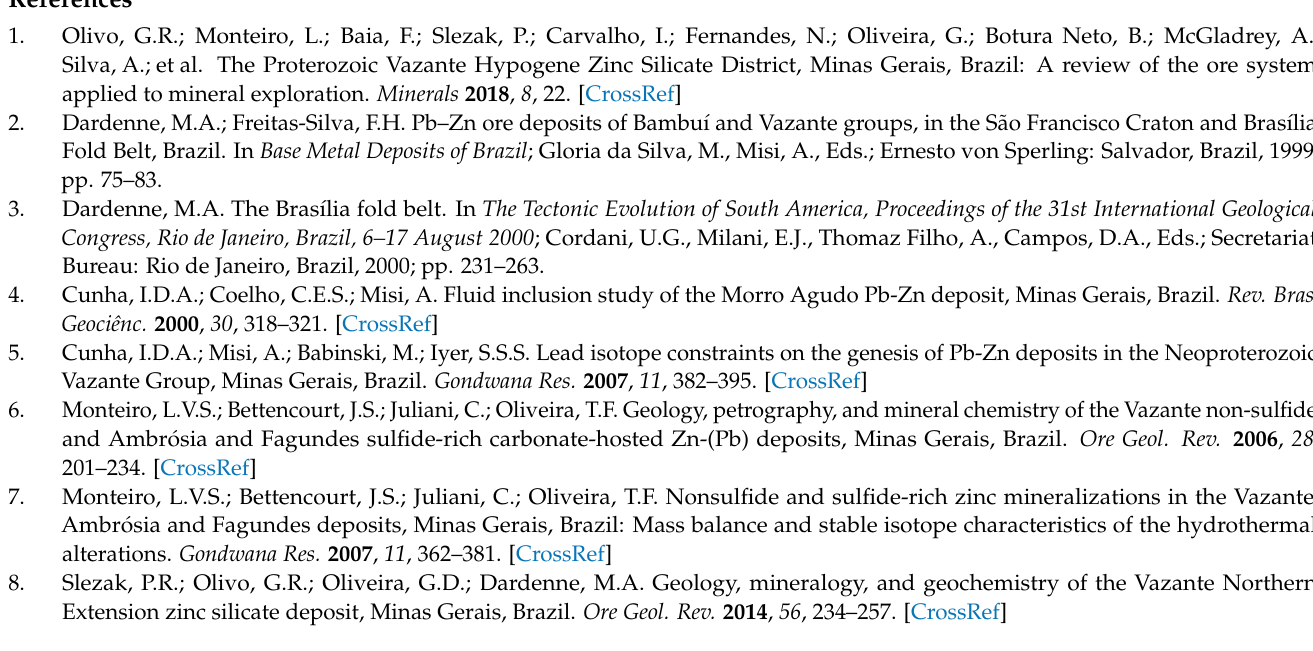
Figure S1. Plot of sphalerite analyses in PC1 (29.2%) vs. PC3 (12.8%) and associated element components. Figure S2. Plot of sphalerite analyses in PC1 (29.2%) vs. PC4 (8.1%) and associated element components. Figure S3. Plot of sphalerite analyses in PC2 (13.0%) vs. PC3 (12.8%) and associated element components. Figure S4. Plot of sphalerite analyses in PC2 (13.0%) vs. PC4 (8.1%) and associated element components. Figure S5. PC1 vs. PC2 of sphalerite analyses showing the distribution from the Morro Agudo District by (A) section of the Morro Agudo deposit, and (B) host rock